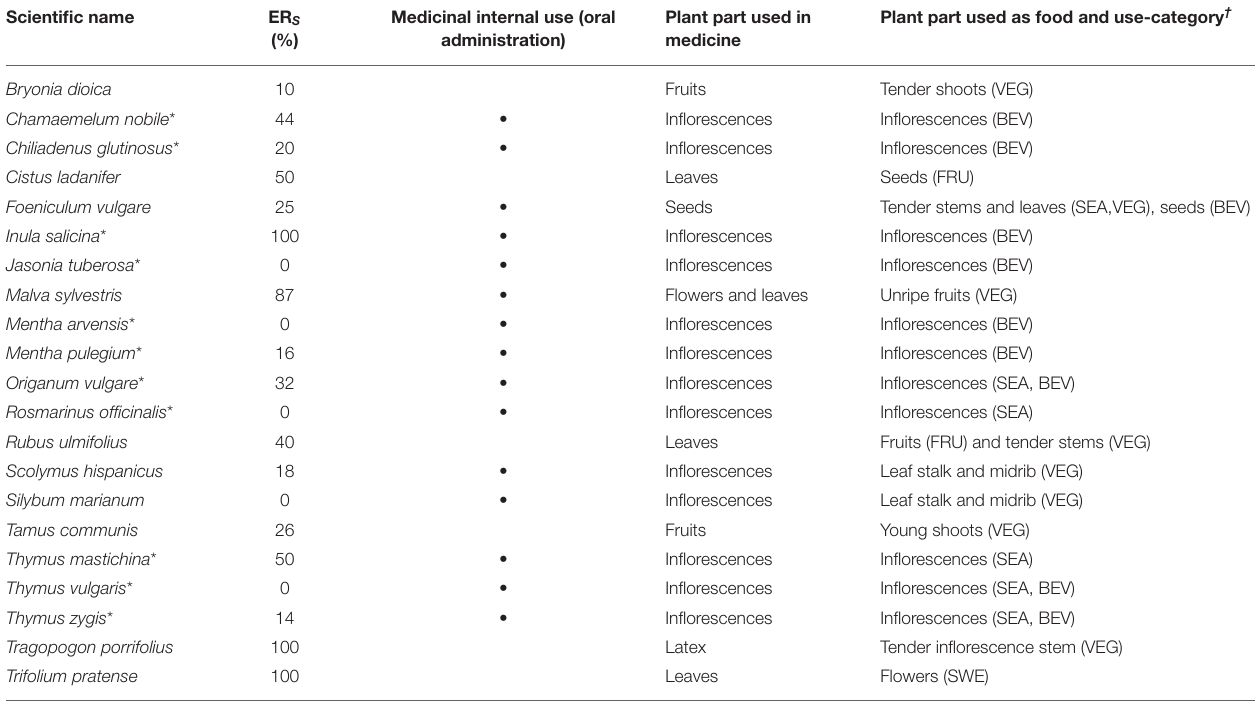
TABLE 3 | Species used both in the categories of medicine and human food in Sierra Norte de Madrid.